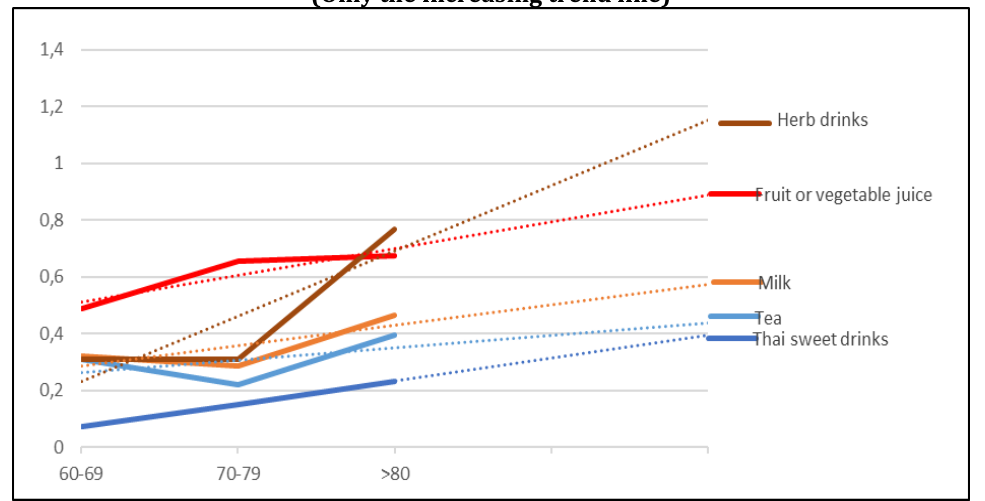
Figure 2: Forecast of Mean Plot between the type of drinks and the range of age (Only the increasing trend line)